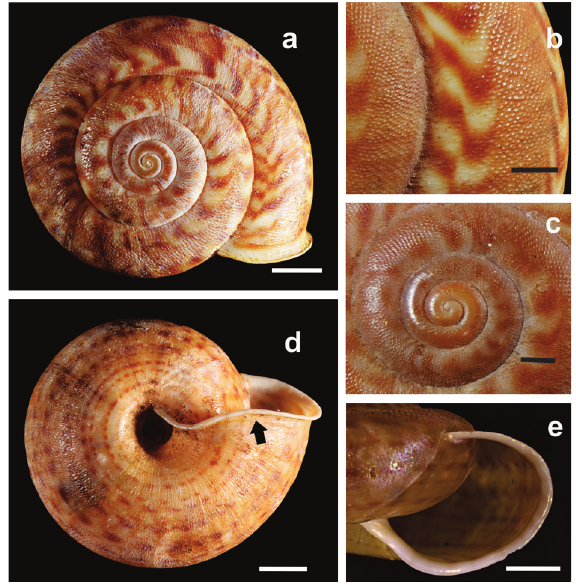
Figure 3 - a , shell morphology of Solaropsis brasiliana . Shell dorsal view (Scale bar = 5 mm); b , detail of the body whorl surface sculpture, arrow point to the double band (Scale bar = 2mm); c , detail of the smooth protoconch and upper whorls (Scale bar = 2 mm); d , shell ventral view (Scale bar= 5 mm); e , shape of the aperture (Scale bar = 5